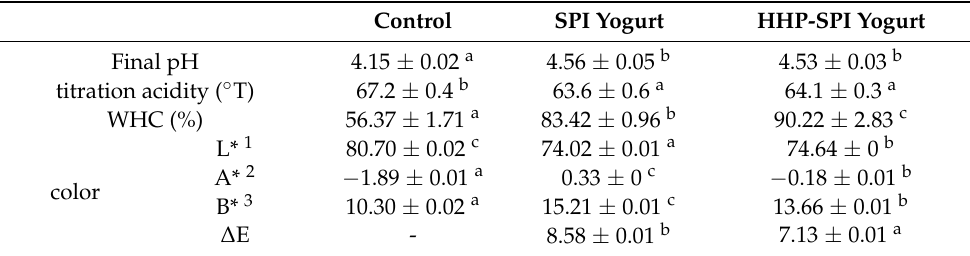
Table 2. The physicochemical properties of yogurt without soy protein isolate (SPI) (control), or with SPI and high pressure treated SPI (HHP-SPI)